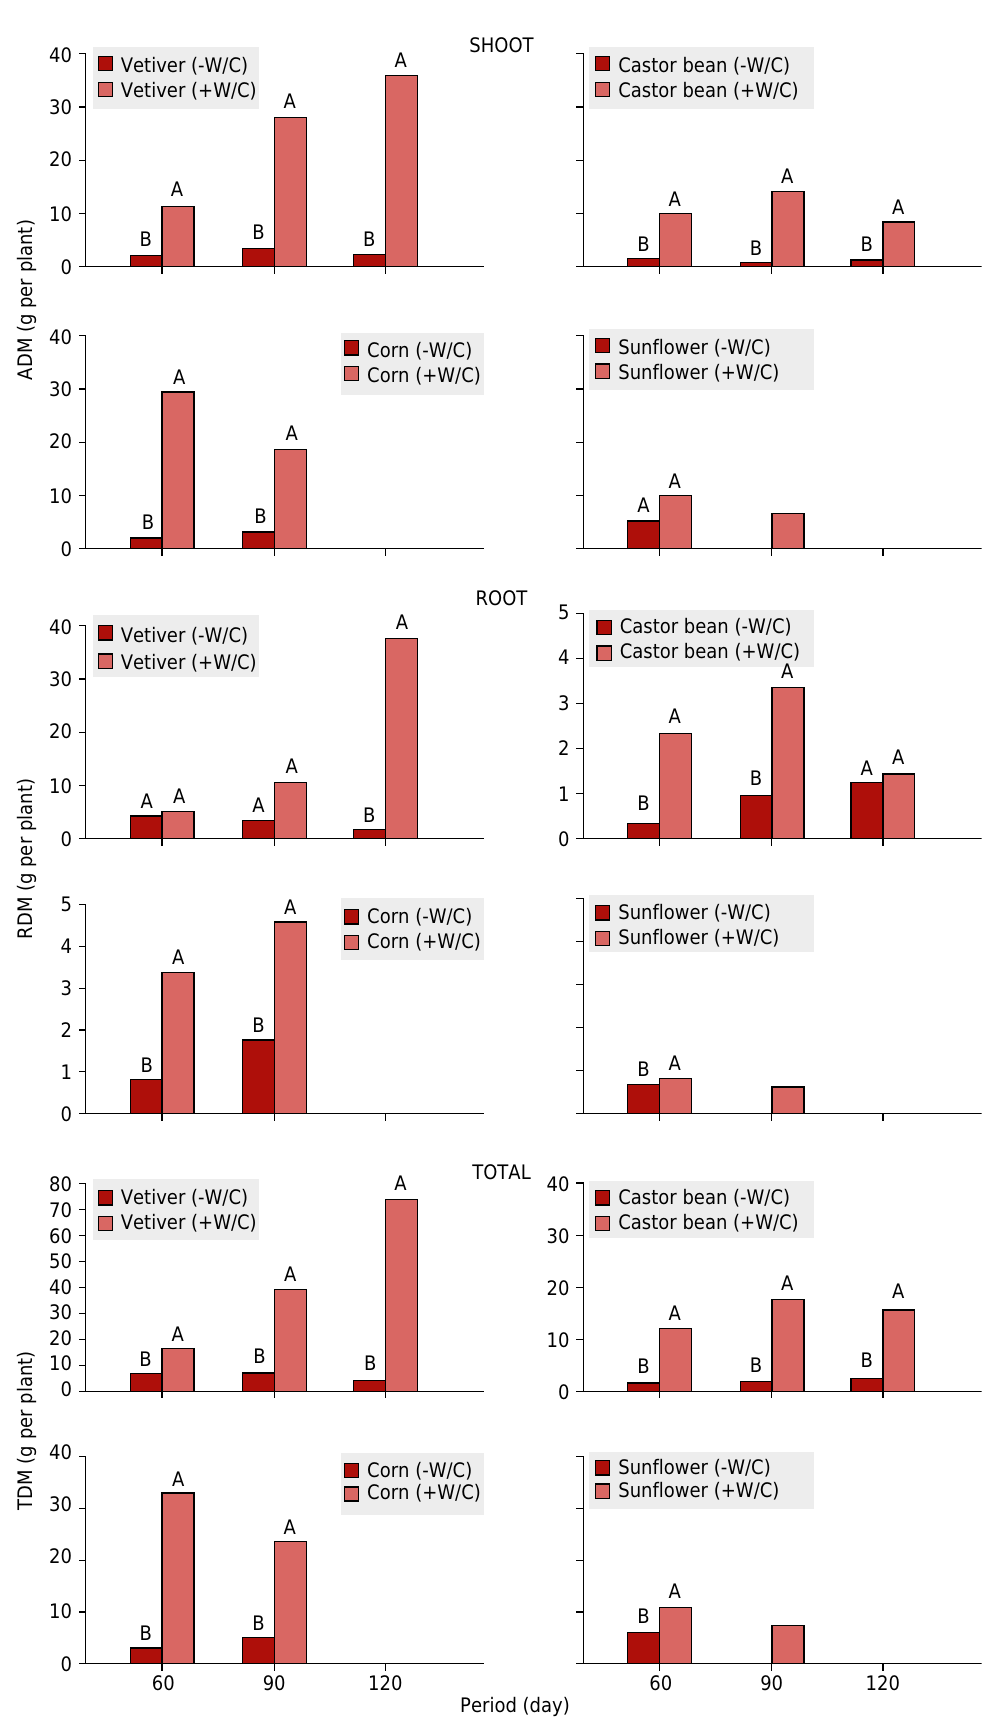
Figure 3. Dry matter contents from the shoots (ADM), roots (RDM), and total (TDM), in vetiver, castor bean, corn, and sunflower plants conducted in contaminated soil, without (-W/C) and with (+W/C)) correction of soil pH, at 60, 90, and 120 days after planting (DAP). Means followed by the same letter, within each period, do not differ among